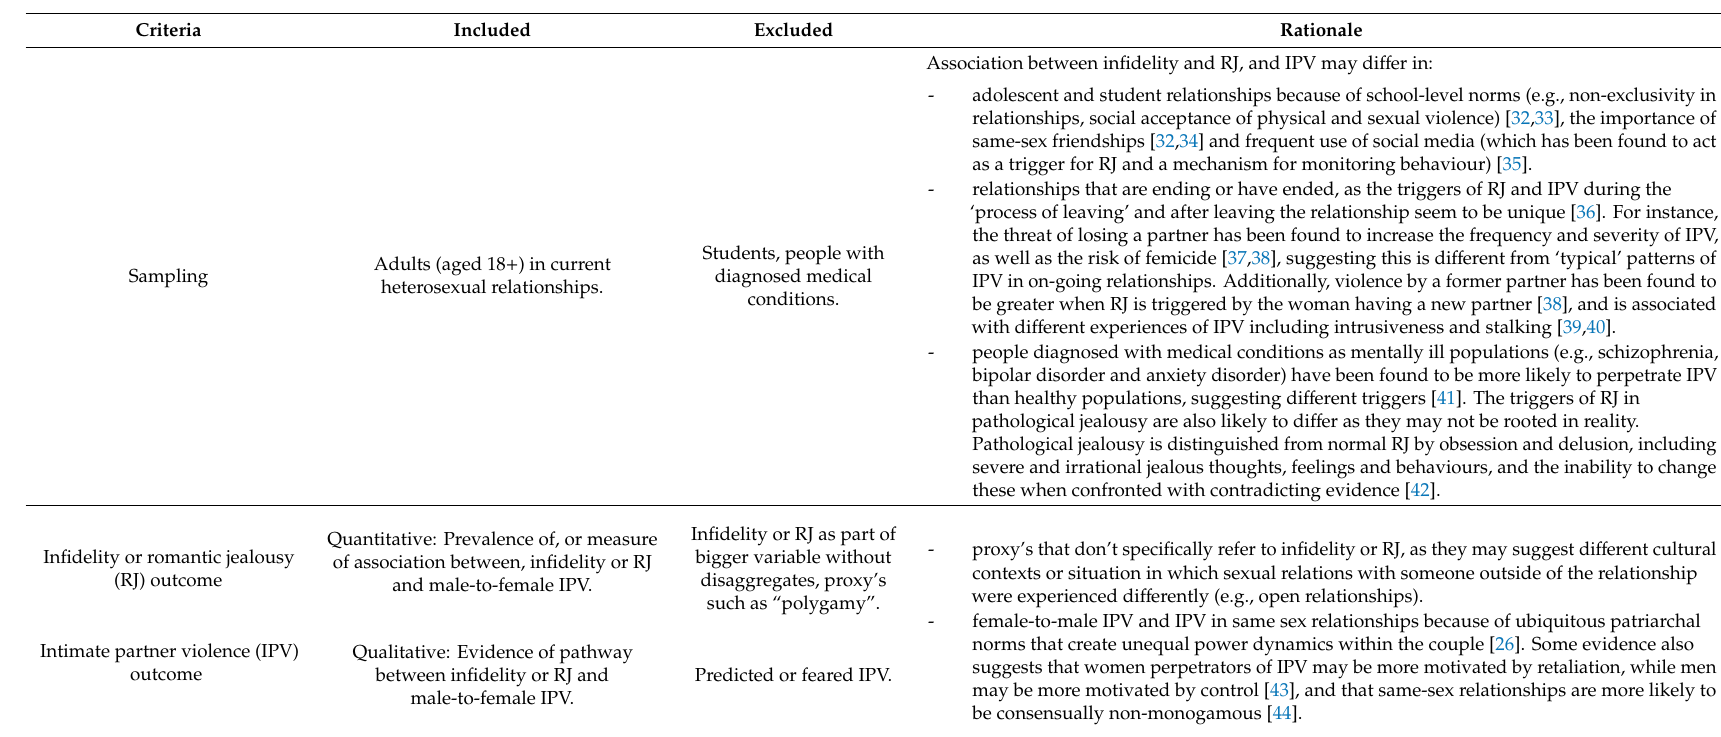
Table 1. Inclusion and exclusion criteria and